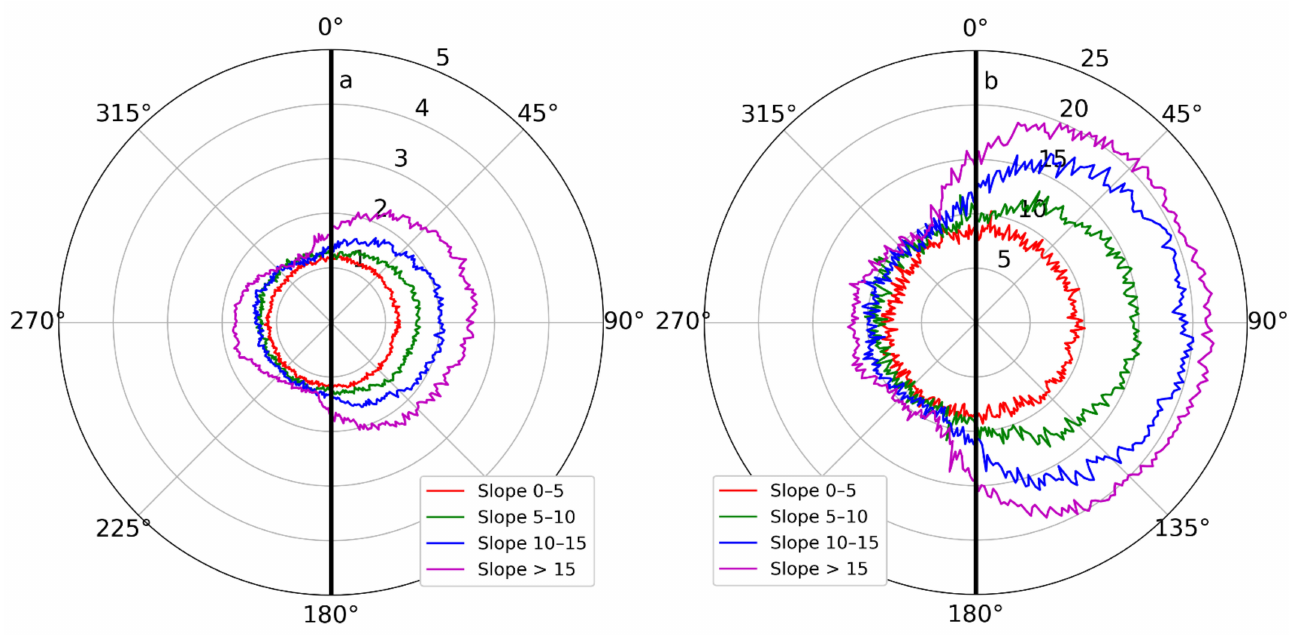
Figure 12. Standard deviation (m) of elevation ( a ) and slope ( b ) differences related to slope orientation angle for different terrain slopes (in degrees).